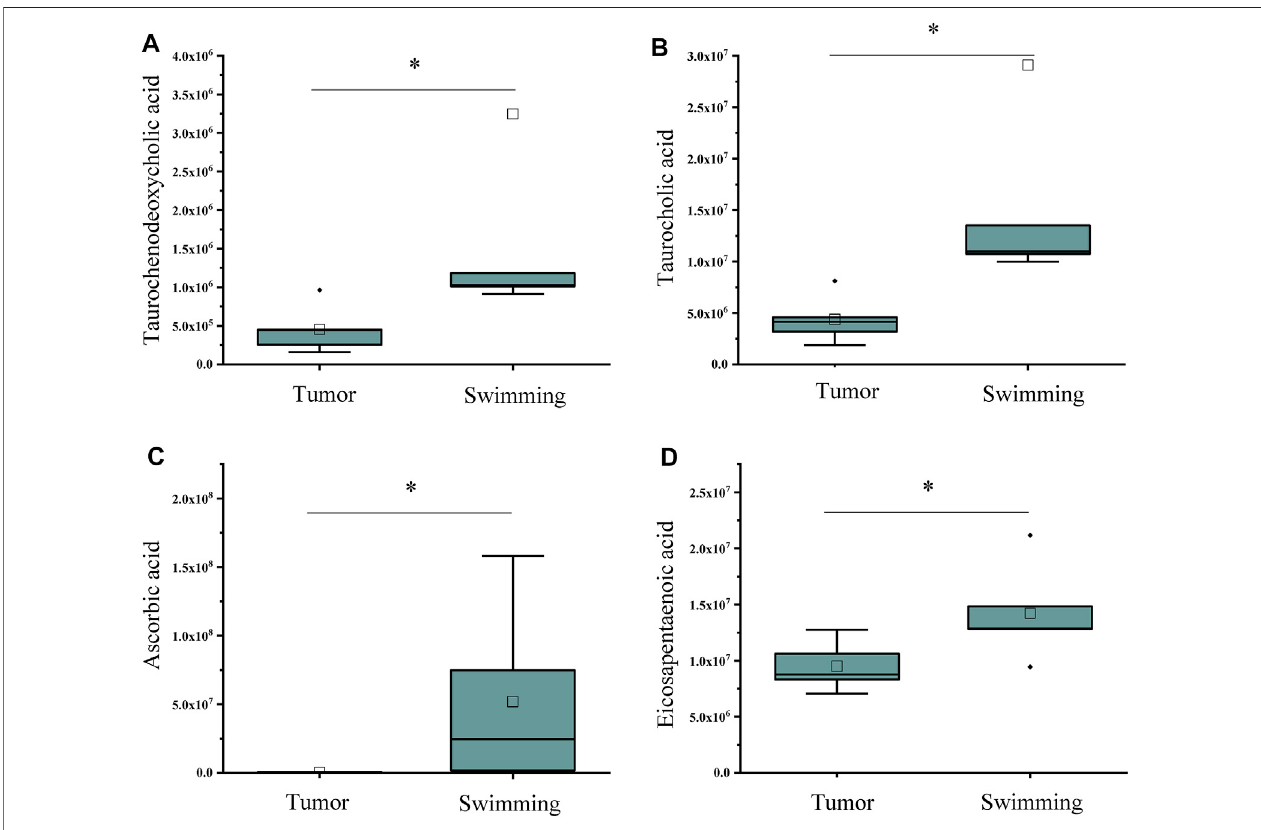
FIGURE 8 | Statistical analysis of differential metabolites associated with in fl ammation and immune regulation. The levels of (A) Taurochenodeoxycholic acid, (B) Taurocholic acid, (C) Ascorbic acid and (D) Eicosapentaenoic acid in muscle tissues between Tumor and Swimming groups. * p < 0.05 vs the Tumor group.